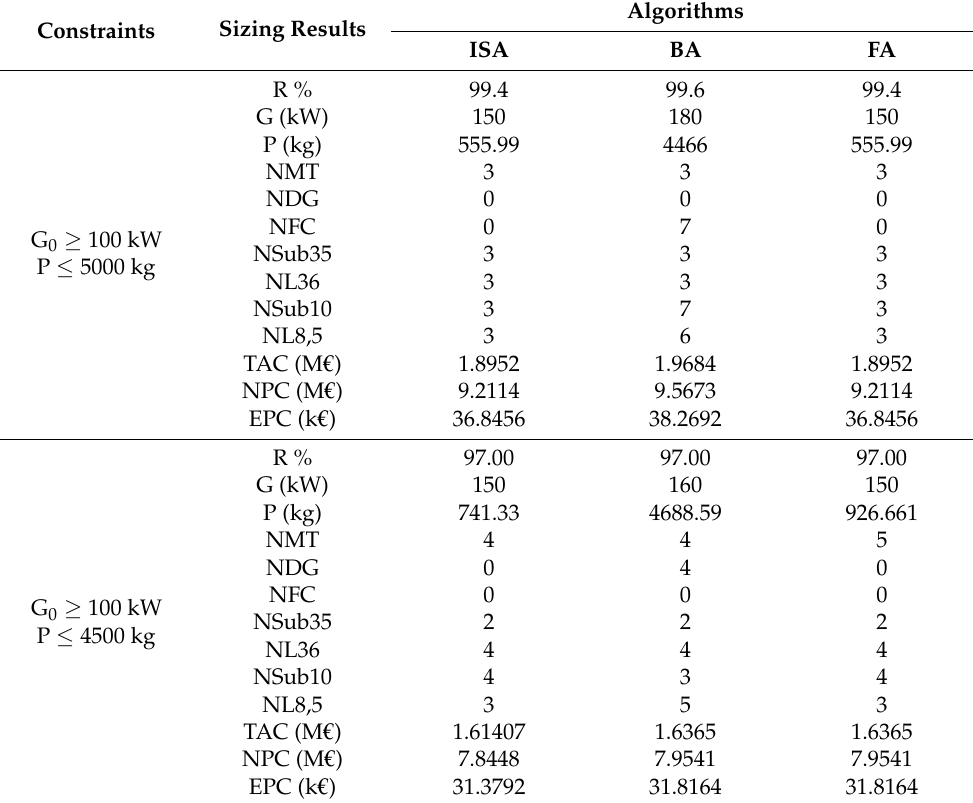
Table 8. Optimization results of the bi-objective function: minimize cost and maximize